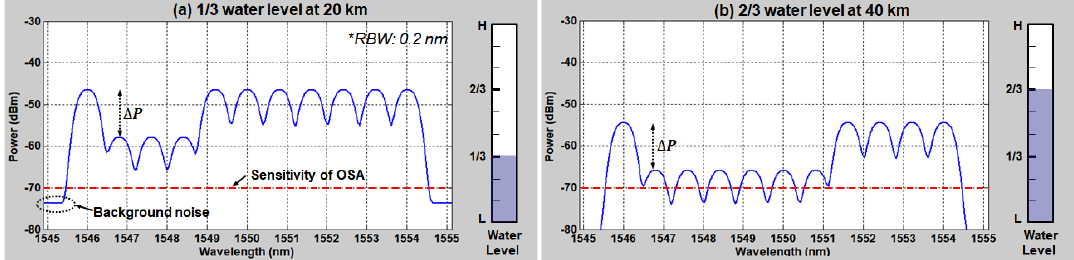
Figure 6. Simulated optical spectra according to the water levels at the di ff erent distances with the proposed network configuration: ( a ) 1 / 3 water level at 20 km and ( b ) 2 / 3 water level at 40 km.